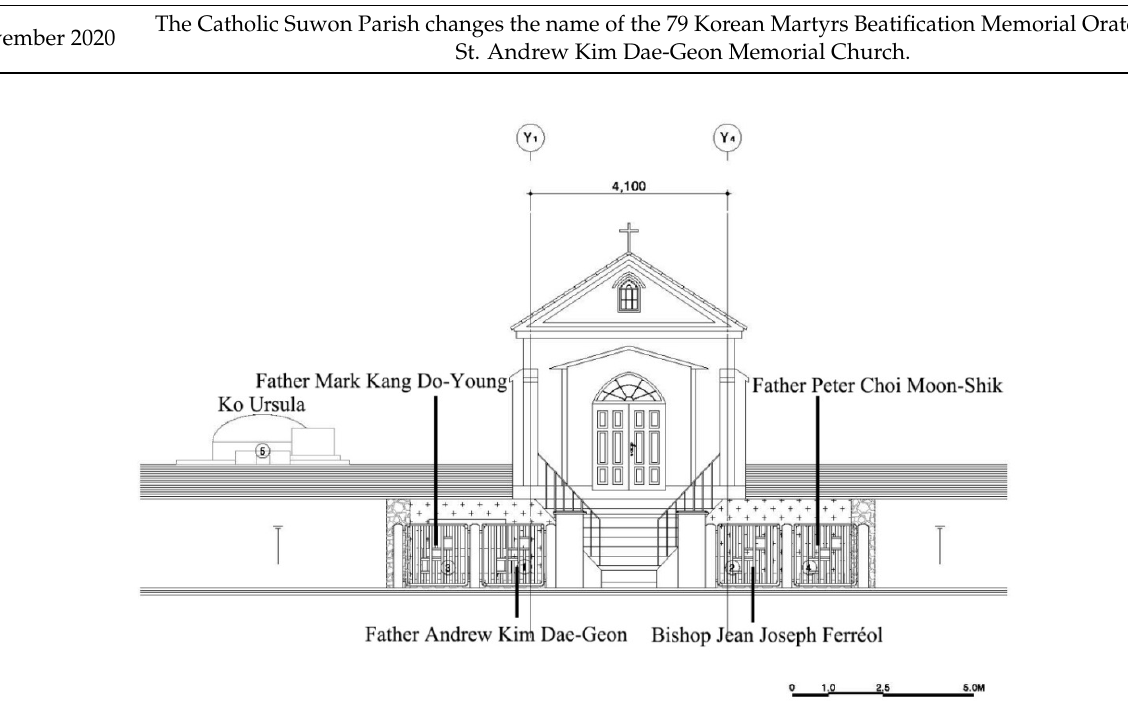
Figure 3. Elevation drawing of the Memorial Church [source: drawing by Heewoo Architecture and Conservation Architects. Co., Ltd.].